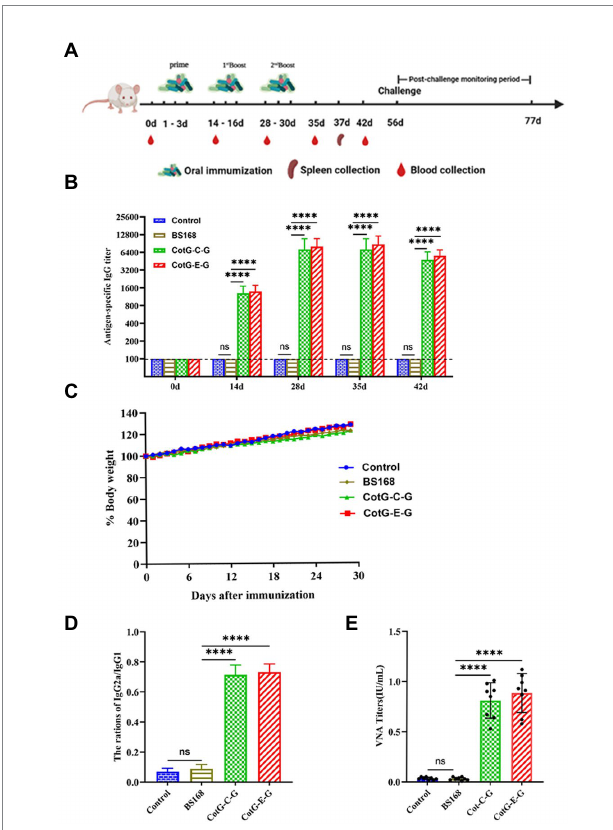
FIGURE 2 Specific anti-RABV antibody detection. (A) Immune scheme, BALB/c mice were randomly divided into 4 group, which were CotG-E-G, CotG-C-G, BS168 and PBS control group. Serum samples were collected at 0, 14, 28, 35 and 42 days ( n = 8/ group). Spleens were collected from mice on day 37 ( n = 3/group). (B) Changes of body weight in mice during immune period. (C) The levels of specific IgG (Serum dilution multiples start from 100 times, sequentially doubling dilution) antibodies in mouse serum were detected by indirect ELISA. (D) One week after the last immunization, the IgG2a/IgG1 ratio was determined by indirect ELISA. (E) One week after the last immunization, VNA titers were determined by the FAVN method. The mean and standard deviation of each group were analyzed using one-way or multi-way ANOVA (* p < 0.05, ** p < 0.01, *** p < 0.001, **** p <